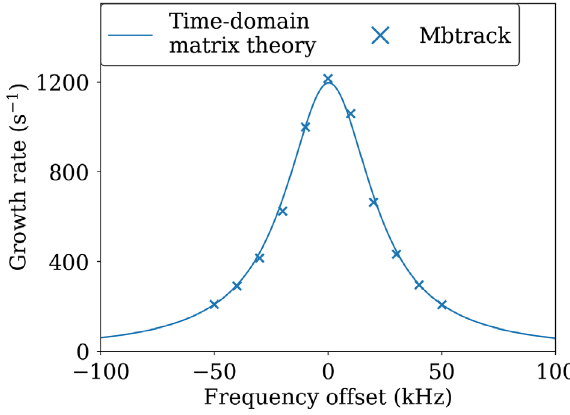
FIG. 5. Growth rates predicted for a uniform fill with point bunches compared to results obtained using MBTRACK . The horizontal axis is the offset in frequency of the HOM from the closest revolution harmonic at 1.09413 GHz.